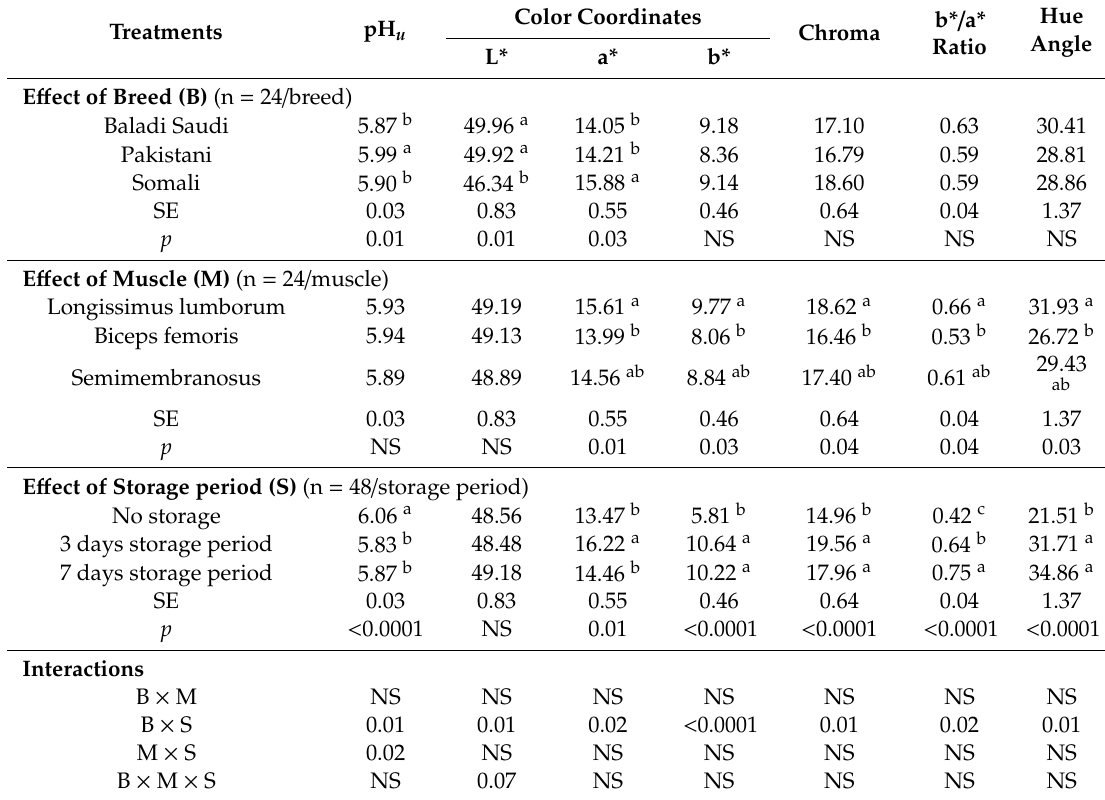
Table 2. E ff ect of breed, muscle type, and storage period and their interactions on pH and color components of camel meat.